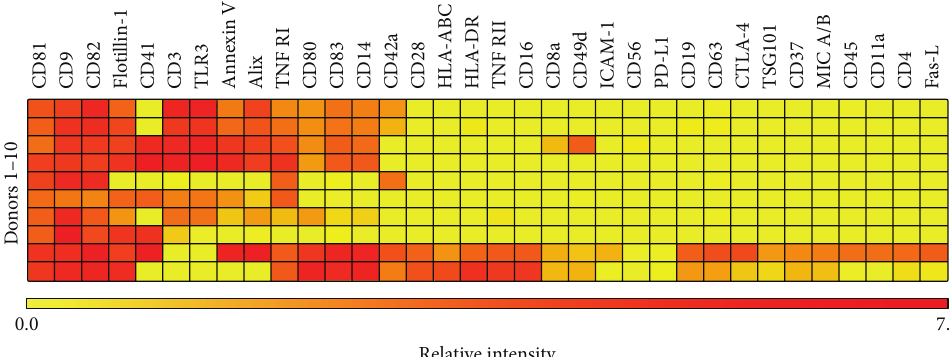
Figure 2: Phenotyping of sEVs present in plasma. Extracellular vesicles present in plasma from 10 healthy donors were investigated for 34 different immune-related or vesicle-related markers using the EV Array. The sEVs were captured by the selected markers and subsequently detected by addition of an antibody cocktail against CD9, CD63, and CD81. The heat map presents the relative intensities for each of the markers as indicated by the colored bar. Data are presented as the mean value of the triplicates from each of the ten